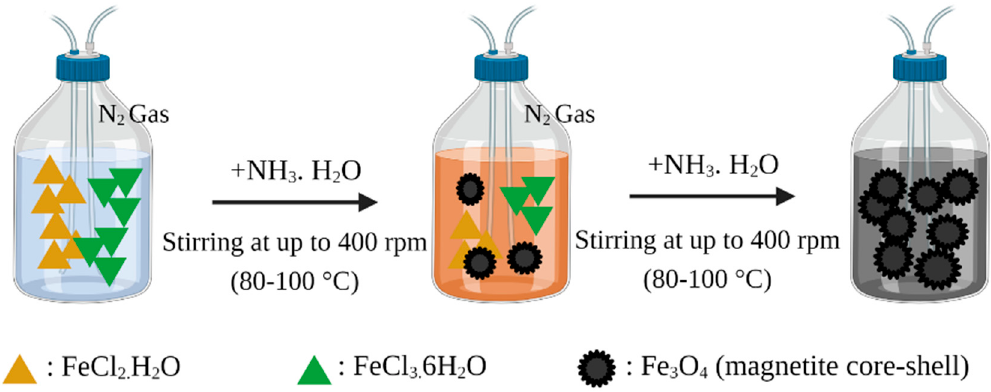
Figure 2. Synthesis of magnetic cores: co-precipitation method.